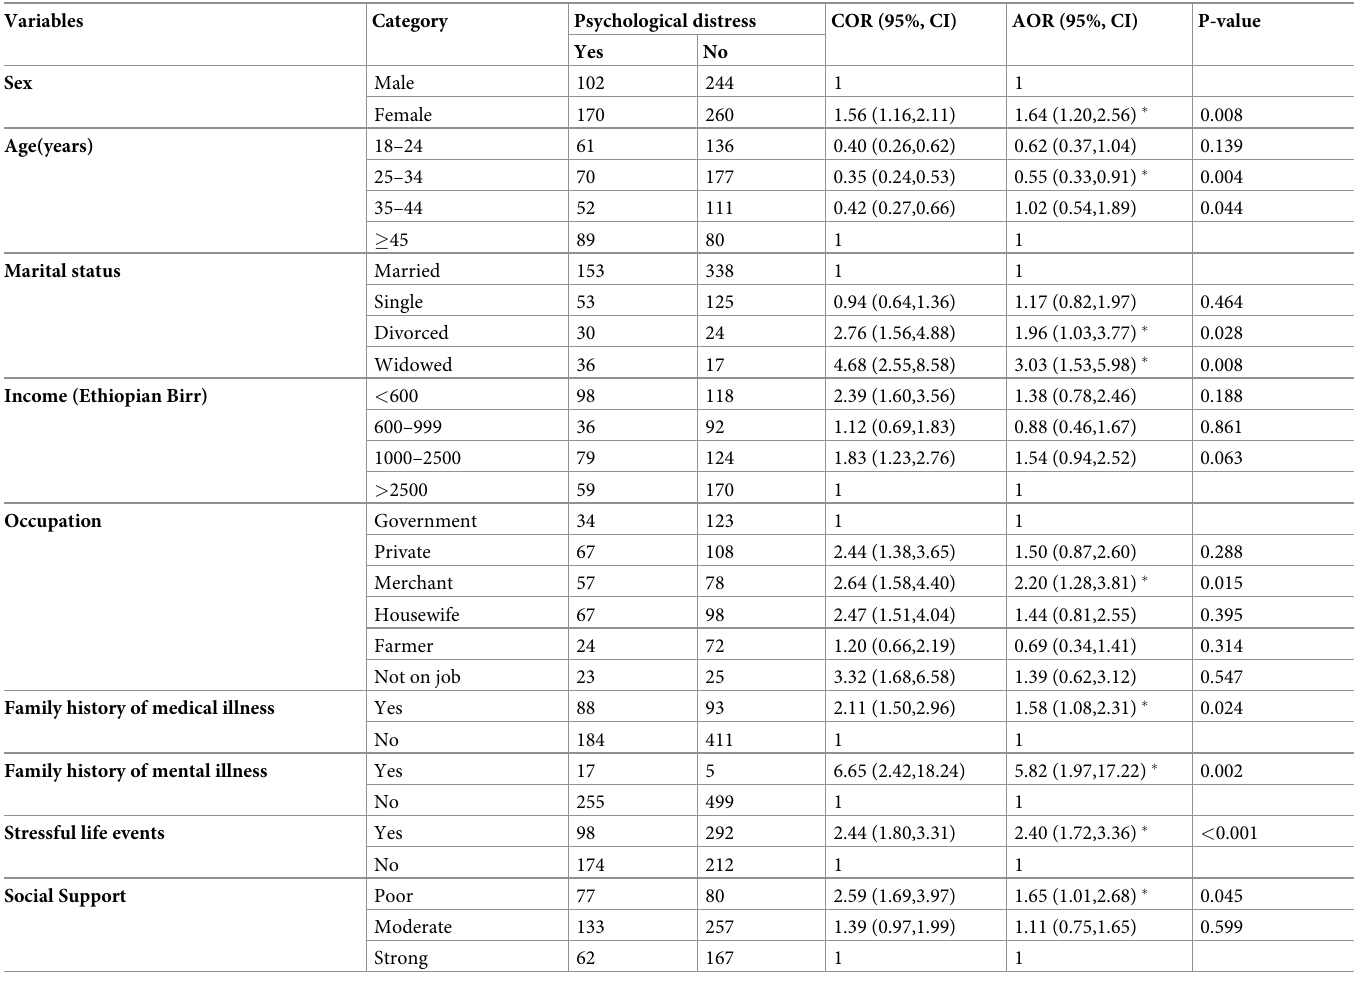
Table 4. Bivariable and multivariable analysis of psychological distress in the general population in Mecha demographic research center, Ethiopia (n = 776). Variables